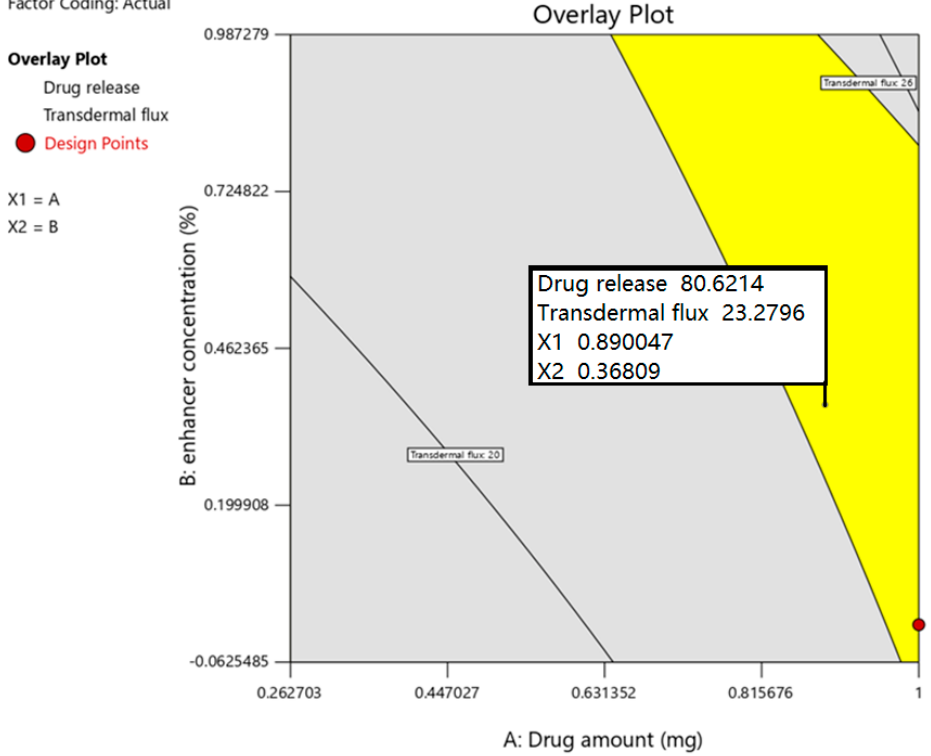
Table 4. Estimated and observed values of dependent variables of the optimized formulation.